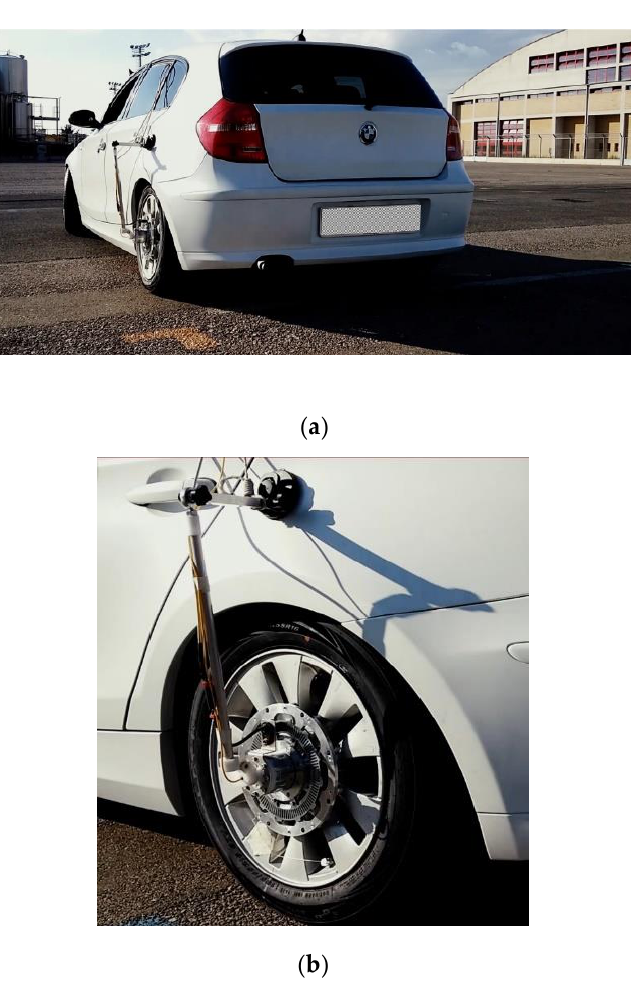
Figure 7. ( a ) The OPTYRE system mounted on the production car during the experimental campaign in operational condition; ( b ) a zoom of the measurement OPTYRE system in operational condition.